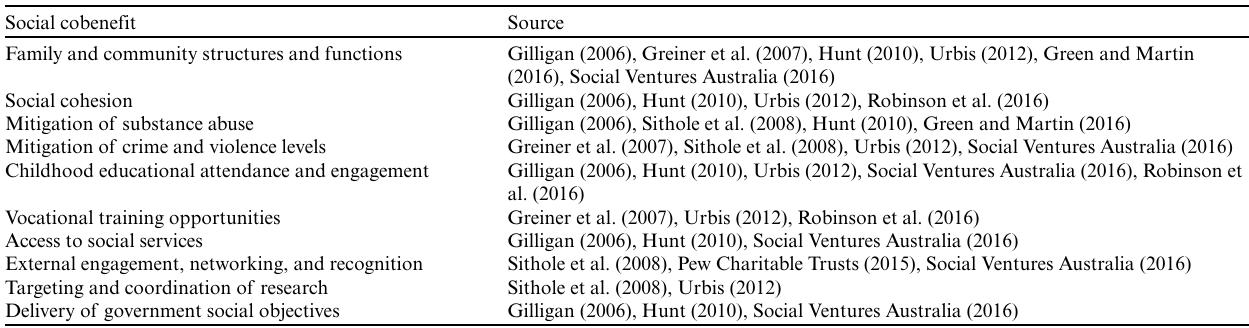
Table 3. Social cobenefits recorded in the Australian indigenous cultural and natural resource management